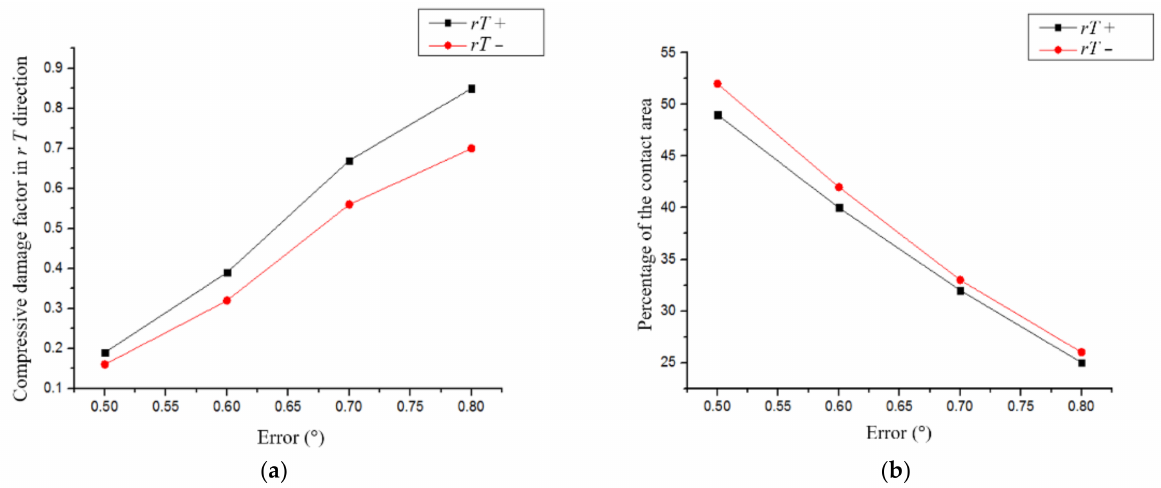
Figure 23. Maximum compression damage factor and T-LZ block contact area under rT direction error. ( a ) Maximum compression damage factor; ( b ) Contact area of the T-LZ block.